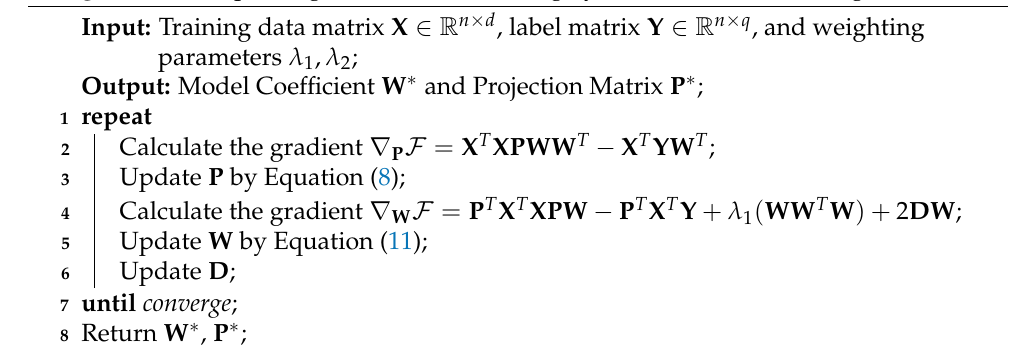
Algorithm 1: Improving Multi-Label Learning by Correlation